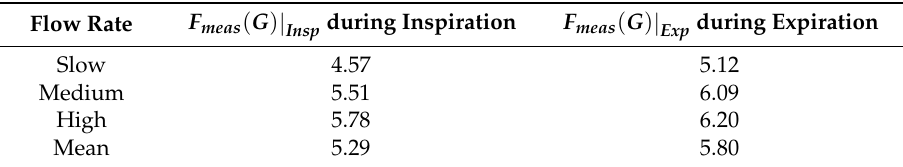
Table 2. ˆ F meas ( G ) computation by analyzing V OUT .